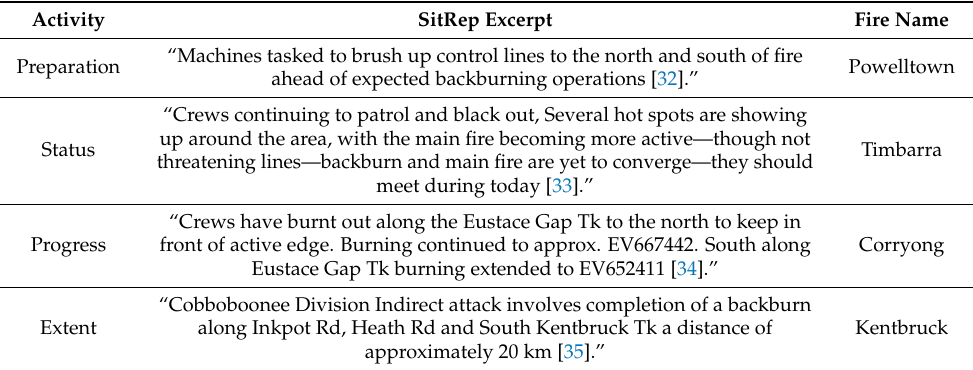
Table 3. Excerpt examples of SitRep comments that describe suppression